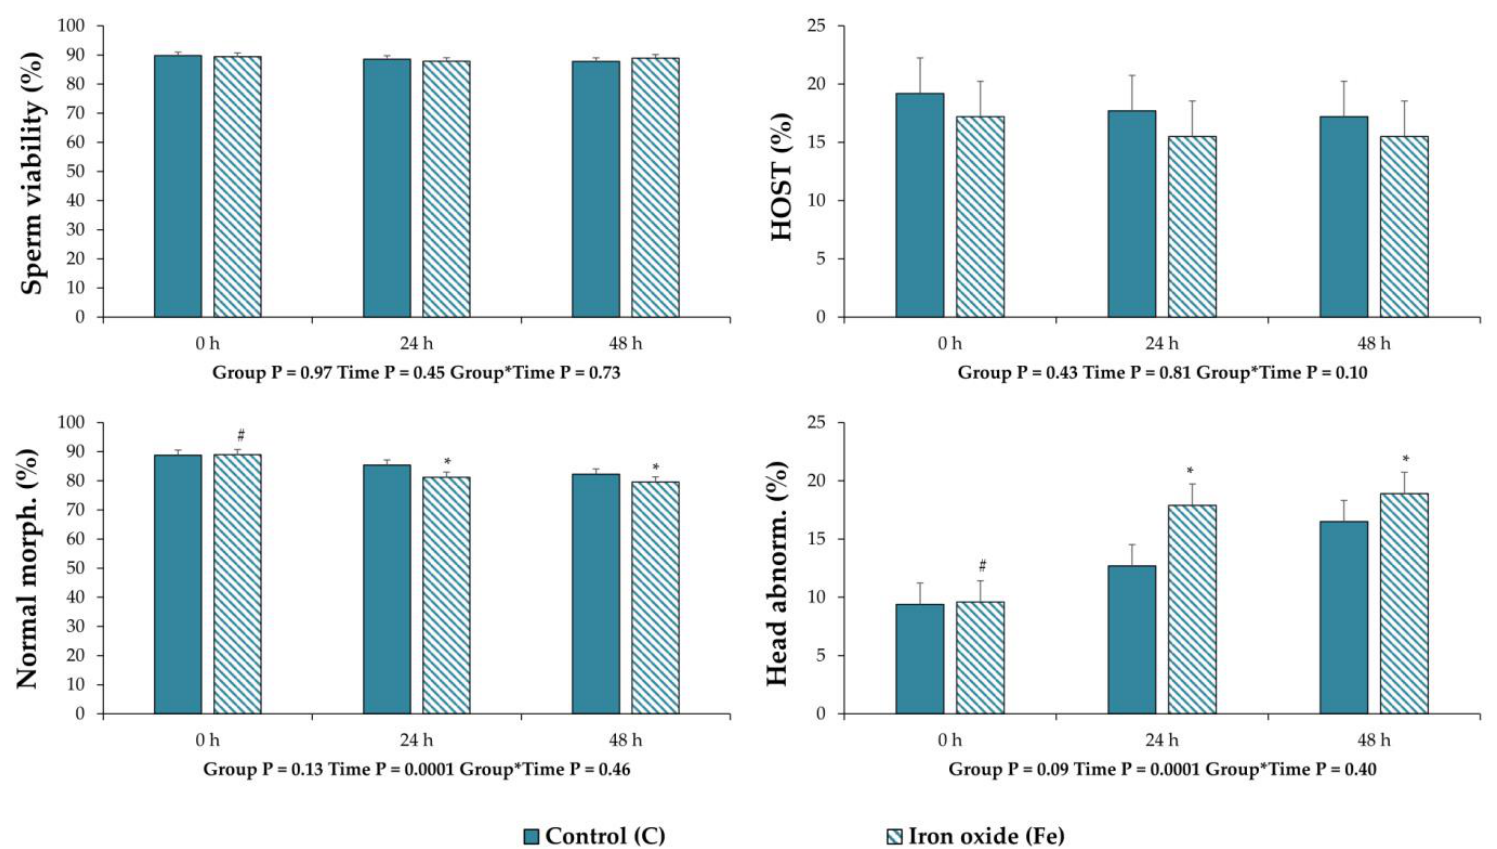
Figure 5. Sperm quality and function variables of extended boar semen samples at 0, 24 and 48 h of storage post treatment with Fe 3 O 4 nanoparticles (NPs). Control group (C): extended boar semen samples without any treatment; Iron oxide group (Fe): extended semen with Fe 3 O 4 NPs (0.192 mg Fe 3 O 4 / mL semen). All the values are expressed as mean ± standard error of the mean (SEM). Different symbols (#, *) denote significant differences between evaluation times within each experimental group.